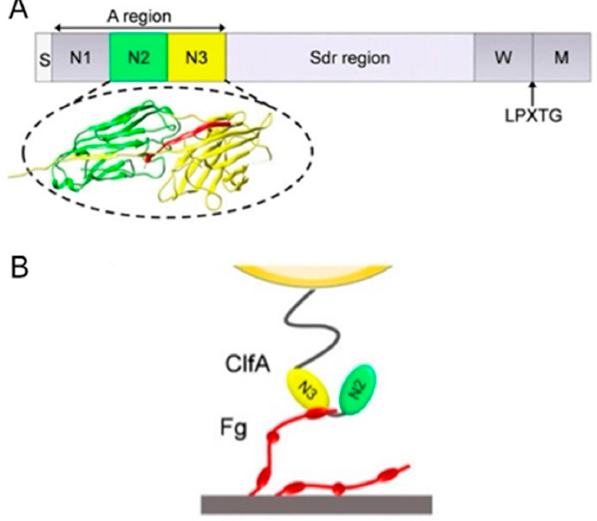
Figure 5. The protein structure of ClfA and its functional mechanism. ( A ) From the N- to C- terminus, ClfA is composed of signal sequence (S), A region with subdomains N1, N2 and N3, repeated serine-aspartate residues (Sdr) region, wall spanning (W) region, LPXTG motif (LPXTG) and sorting sequence (M). The binding site of Fg is between N2 (green) and N3 (yellow). ( B ) The γ -chain of Fg (red) binds to the trench between N2 and N3. Adapted from Herman-Bausier et al. [97]. The diversity of ClfA has been explored by studies on its variants. The results ob- tained from structural mapping of CflA subdomains reveal a minimum pairwise identity of 86%, which indicates a low level of structural differences among variants. Therefore, ClfA is considered to be well-conserved, and also one single isolate is predicted to be able to generate cross-reactive antibody responses against a wide range of variants [96]. How- ever, this predication is questioned by a further study, which has shown that ClfA strains present lower binding affinities to heterologous antibodies elicited by their variants, with only 10% variation in aminoacid sequences [102]. This result highlights that small differ- ences in composition across S. aureus strains could result in large effects on antigenicity. Interestingly, as a member of the MSCRAMM family, S. aureus ClfA shows force sen- sitivity, and its binding to Fg is significantly enhanced by mechanical force, which shows that the ClfA—Fg binding is increased 15-fold in the presence of mechanical tension [97]. According to the same study, ClfA interacts with Fg via two distinct binding sites, and the stronger binding site is favoured by high shear stress [97]. This mechanical sensitivity of ClfA shows high biological significance to PVE. As mentioned in Section 1.2, the pathol- ogy of PVE is critically related to the changed haemodynamics after aortic valve replace- ment, which causes turbulent flow that can lead to elevated shear stress levels in the as- cending aorta [103]. The elevated shear stress caused by the implantation of the prosthetic valve has been proved by a series of past studies, and a maximal stress of 500 N/m 2 has been indicated [103,104]. This can probably benefit S. aureus attachment on the prosthetic valve through enhancement in ClfA—Fg binding. However, the confirmation of a poten- tial association between the mechanical sensitivity of ClfA and the pathology of PVE would require deeper investigations. For the reasons mentioned above, antibody treatments targeting MSCRAMM ClfA could possibly prevent the incidence of IE and especially PVE, and indeed, the therapeutic potential of anti-ClfA antibodies has been evidenced by many studies [44,50,51,84,105]. The application of tefibazumab, a humanised anti-ClfA mAb, contributed to the preven- tion of IE in a rabbit model [44]. However, tefibazumab has failed to achieve statistically significant improvement in a phase II human clinical trial (ClinicalTrials.gov Identifier: